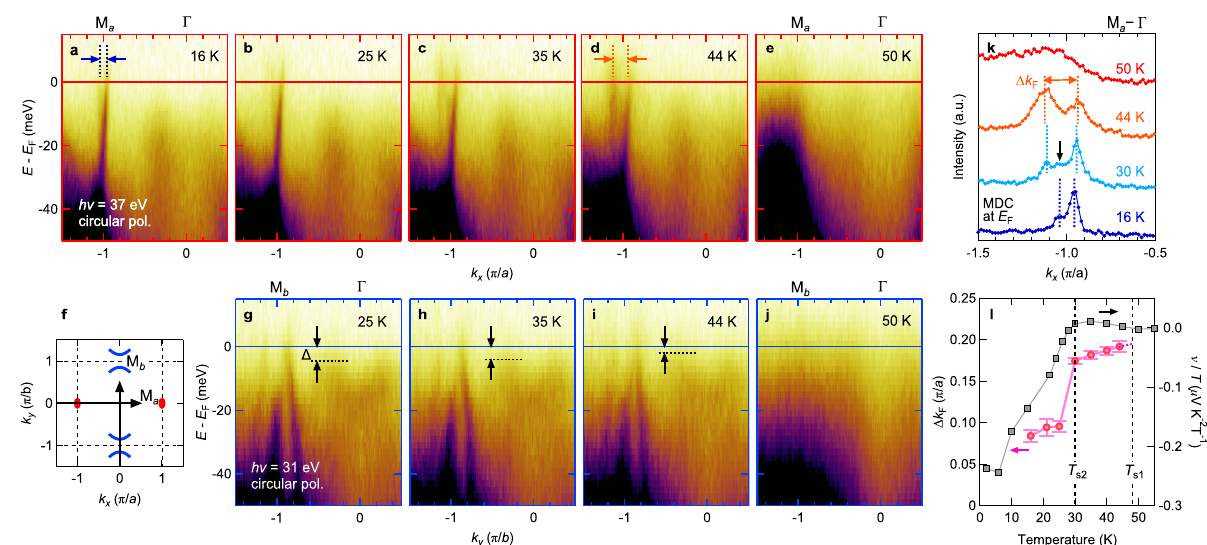
Fig. 3 Two-stage temperature evolution of the band structure. a – j Energy distribution maps along M a -- Γ (top panels) and M b -- Γ (bottom panels) for temperatures as indicated. The gap Δ of the electron pocket around Γ is indicated in g – i . For detailed analysis, see Supplementary Fig. S4. f Schematics of the Fermi surface and the high-symmetry cuts used in a – e and g – j . k MDCs at E F (integrated within ± 3 meV) for temperatures as indicated. Vertical dashed lines de fi ne MDC peak maxima. A clear difference in the peak separation, Δ k F , is found across 30 K. At 30 K, a three-peak structure is found and indicated by the black arrow and the two dashed lines. l Δ k F plotted as a function of temperature. The error bars represent 3 σ of the fi tting with σ being the standard deviation. For comparison, the Nernst coef fi cient ν 14 is plotted as ν / T versus T . Both experiments suggest an electronic transformation across T = 30